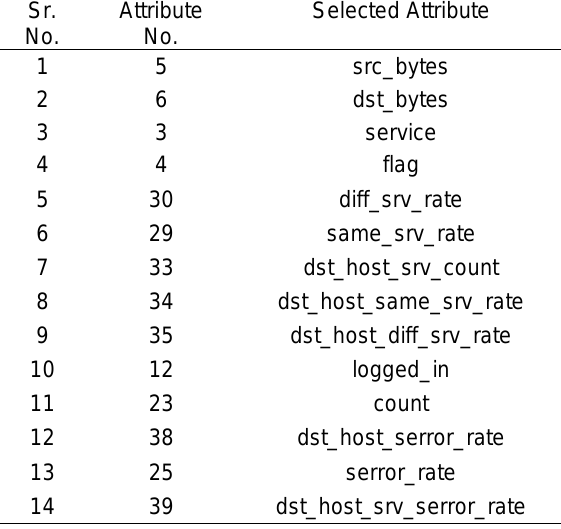
Table 4. Top 14 ranked features using